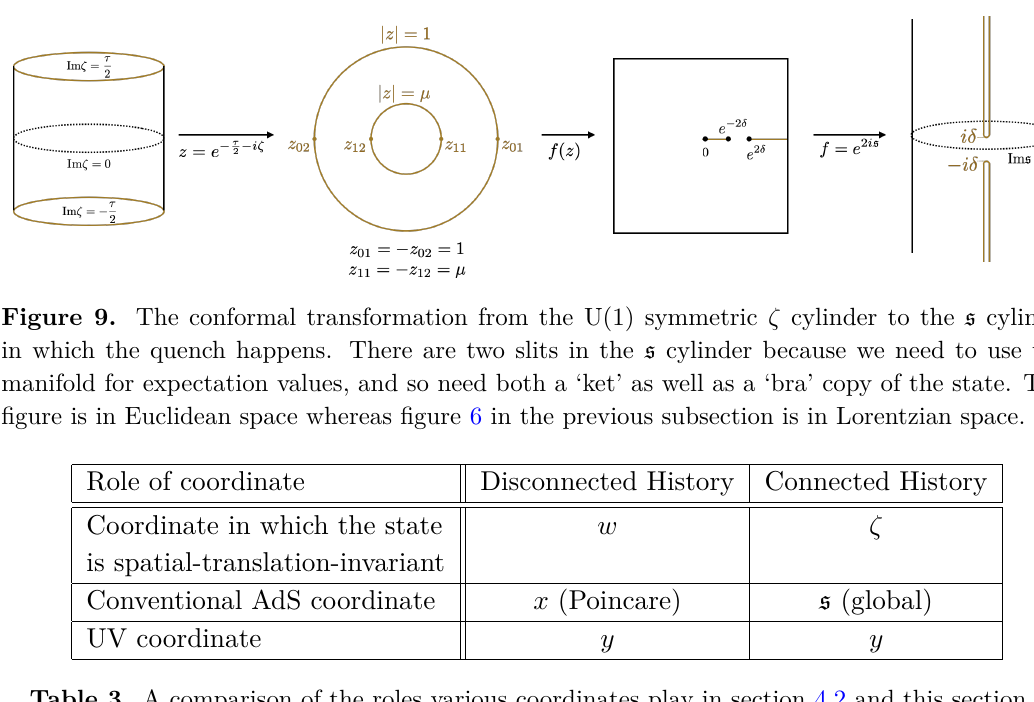
Table 3. A comparison of the roles various coordinates play in section 4.2 and this